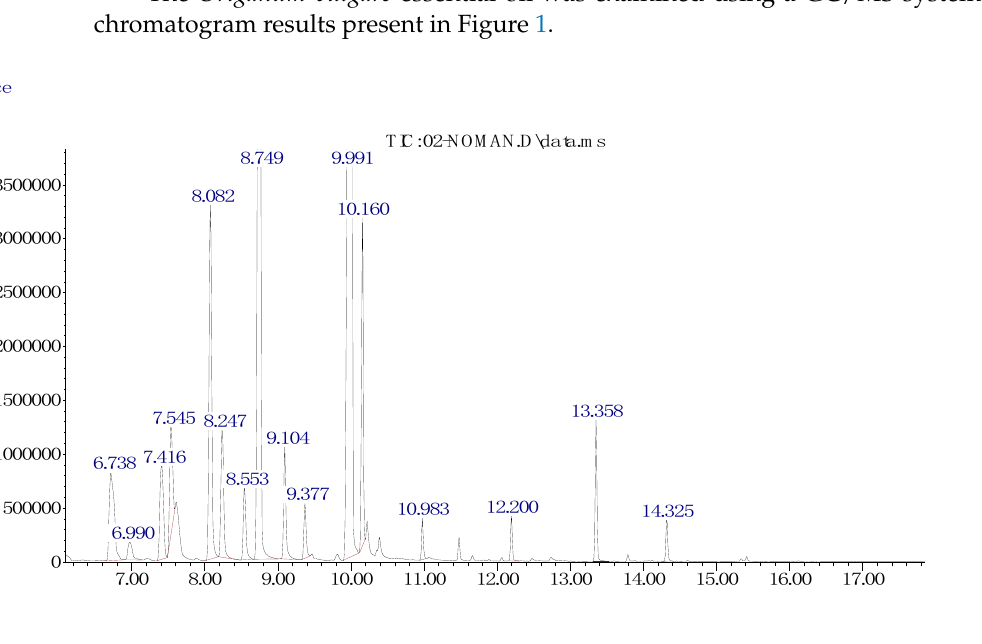
Figure 1. GC-MS chromatogram of Origanum vulgare .